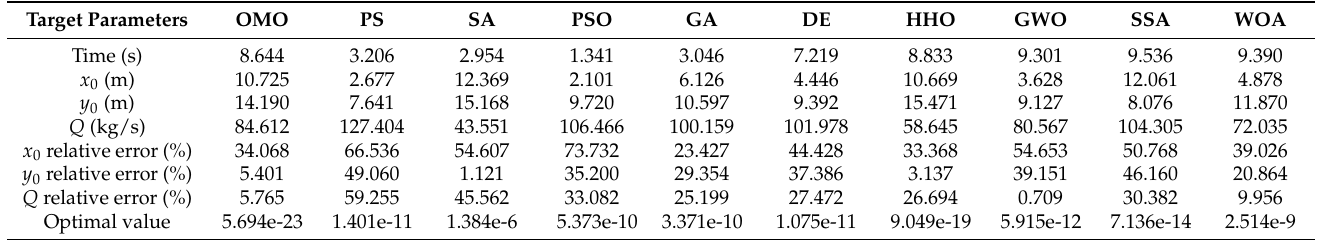
Table 18. Comparison of results of different optimization algorithms under 4